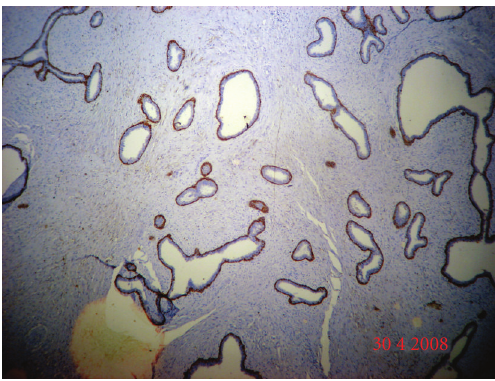
Figure 1: Fibroadenoma in this figure shows highlighted myoep- ithelial cells by CD10. There was no expression of CD10 in normal ductal cells, fibroblasts.